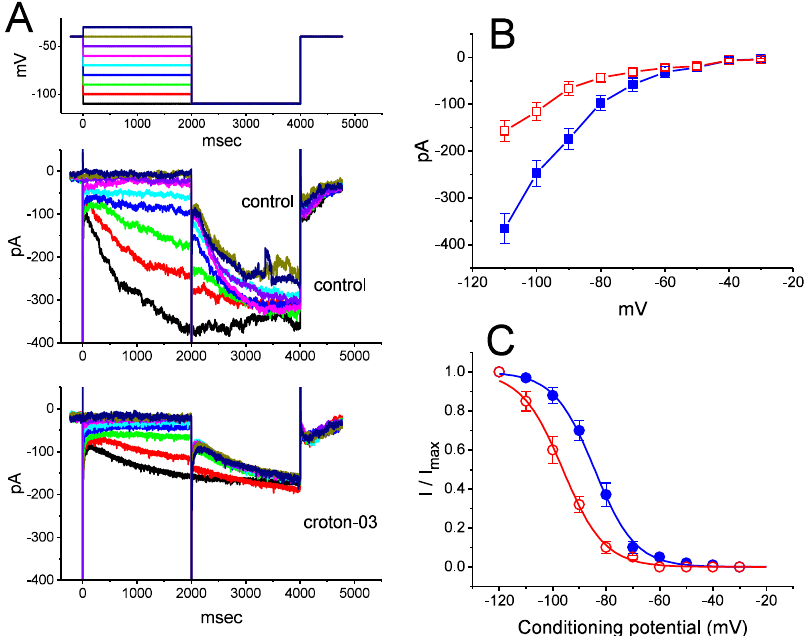
Figure 2. Effect of croton-03 on averaged I-V relationship and steady-state activation curve of I h in GH 3 cells. In this set of voltage-clamp current recordings, the conditioning voltage pulses with a duration of 2 sec to potential ranging from -120 and -30 mV. After each conditioning pulse, a test pulse to -110 mV was applied to evoke I h for measurement of the steady-state activation curve of the current. The upper part of (A) indicates the voltage protocol applied. An example of current traces obtained by this two-pulse protocol is illustrated in ( A ). ( B ) Averaged I-V relationship of I h in the control ( ■ ) and during the exposure to 3 μM croton-03 (□). Current amplitude was measured at the end of each membrane (i.e., conditioning) potential applied. Each point represents the mean ± SEM ( n = 7 for each point). ( C ) Effect of croton-03 on the steady-state activation curve of I h in the absence (●) and presence (Ο) of 3 μM croton-03 in GH 3 cells. The I h amplitudes were normalized with those measured at the end of each test pulse and then constructed against the conditioning potentials. The continuous line was least-squares fitted by the Boltzmann equation (see text for details). Please note that the steady-state activation curve of I h in GH 3 cells was significantly shifted toward hyperpolarizing voltage during the exposure to croton-03.